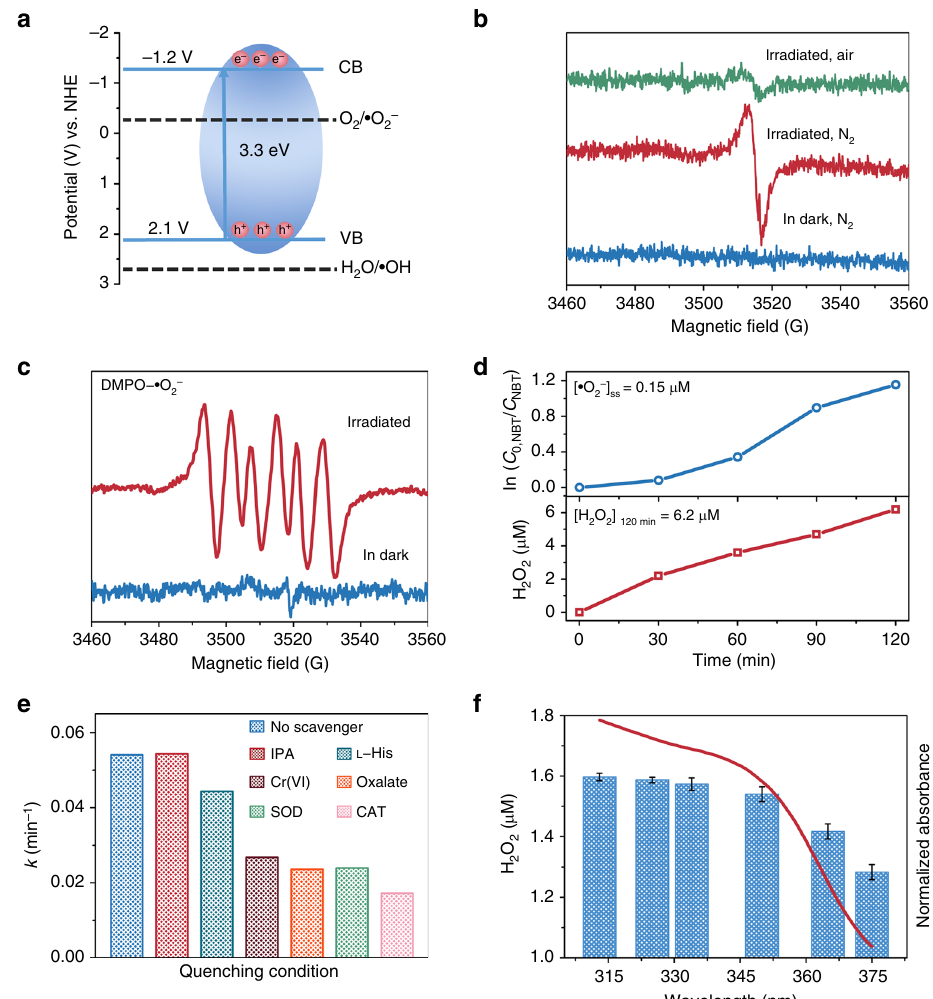
Fig. 3 Band-structure characterization and photocatalytic disinfection mechanism of ZIF-8 (zinc-imidazolate MOF). a The band positions of ZIF-8 with respect to the reactive oxygen species (ROS) formation potential. Conduction band (CB) and valence band (VB) represent conduction band and valence band respectively. b Electron paramagnetic resonance (EPR) spectra of ZIF-8 at 77 K in dark and under light irradiation (300 nm < λ < 1100 nm) in different atmosphere. c EPR spectra of DMPO − (cid:129) O 2 − for ZIF-8 under light irradiation and in dark. d Steady-state concentration of (cid:129) O 2 − calculated from the decay of nitroblue tetrazolium (NBT) and hydrogen peroxide (H 2 O 2 ) accumulation over time, respectively. e The fi rst-order disinfection rate on ZIF-8 with different scavengers (IPA → (cid:129) OH, L -His → 1 O 2 , Cr(VI) → e − , Oxalate → h + , SOD → (cid:129) O 2 − , CAT → H 2 O 2 ). f Dependence of the amount of released H 2 O 2 by ZIF-8 on the wavelength of incident light and the ultraviolet – visible (UV – vis) spectra of ZIF-8. The error bars are calculated via repeating the measurements for three times. SOD superoxide dismutase, IPA isopropanol, DMPO 5,5-diemthyl-1-pyrroline